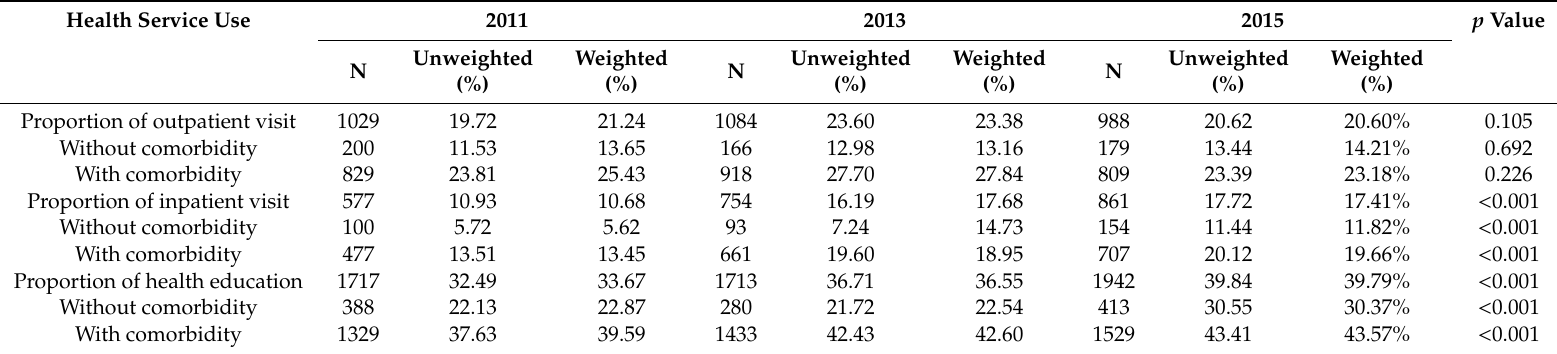
Table 3. Trends in the health service use among people with hypertension by comorbidity status in China from 2011 to